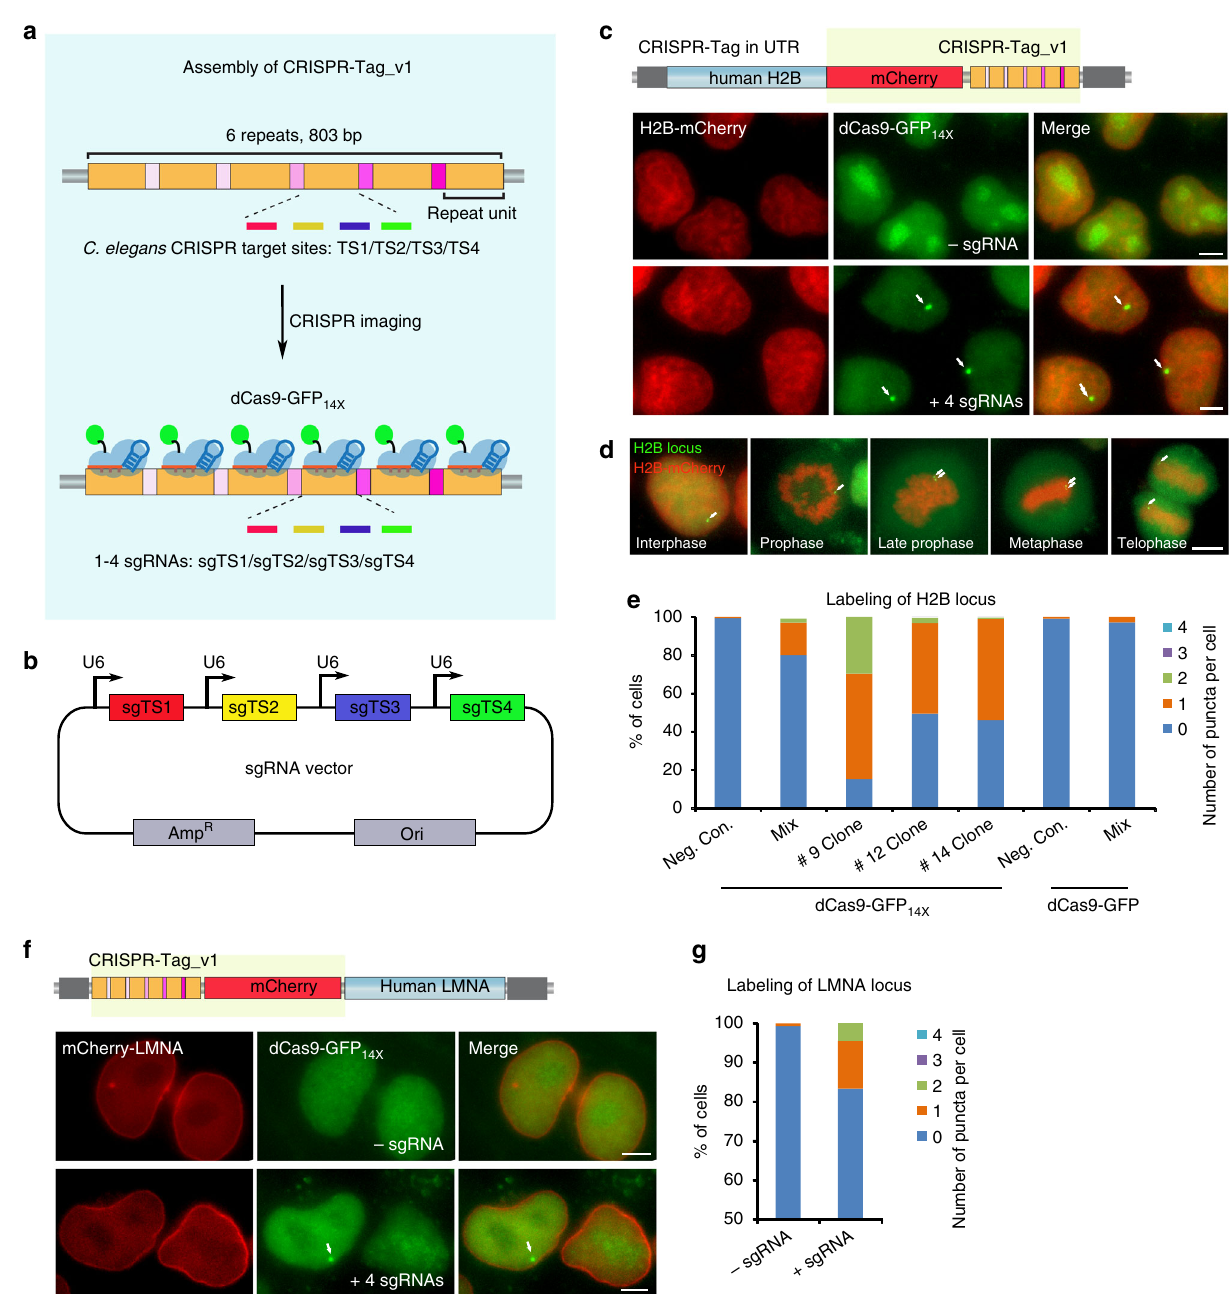
Fig. 1 Development of CRISPR-Tag to label non-repetitive genes. a Schematic of CRISPR-Tag design as a DNA tagging system. b Co-expression of four sgRNAs in one vector. sgTS1, sgTS2, sgTS3, and sgTS4 were built individually and then sub-cloned into a single vector. c mCherry-CRISPR-Tag_v1 was inserted into C-terminus of human H2B gene as highlighted by yellow. Representative images denoted simultaneous visualization of H2B-mCherry and H2B loci by using CRISPR-Tag. H2B loci were labeled by dCas9-GFP 14X with four sgRNAs (sgTS1 – sgTS4). d H2B-mCherry and H2B loci were visualized at different stages of cell cycles. e Quanti fi cations of H2B locus labeling ef fi ciency, n ≥ 84 cells. f Representative images to show simultaneous visualization of mCherry-LMNA and LMNA loci by utilizing the CRISPR-Tag system. g Quanti fi cations of LMNA locus labeling ef fi ciency, n ≥ 150 cells. All images in c , d , and f are maximum intensity projections from z stacks. Scale bars: 5 µ